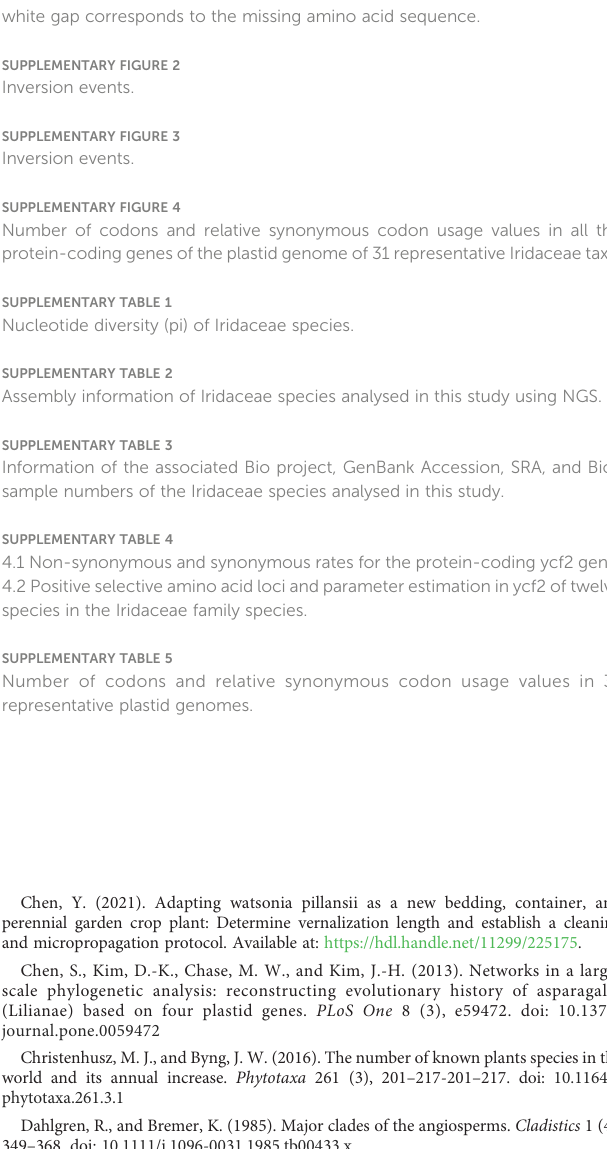
SUPPLEMENTARY FIGURE 1 Gene locus deletion in ycf 2 gene shared by the sampled species of three subfamilies — Crocoideae, Nivenioideae and Aristeoideae — of Iridaceae. The white gap corresponds to the missing amino acid sequence. SUPPLEMENTARY FIGURE 2 Inversion events. SUPPLEMENTARY FIGURE 3 Inversion events. SUPPLEMENTARY FIGURE 4 Number of codons and relative synonymous codon usage values in all the protein-coding genes of the plastid genome of 31 representative Iridaceae taxa. SUPPLEMENTARY TABLE 1 Nucleotide diversity (pi) of Iridaceae species. SUPPLEMENTARY TABLE 2 Assembly information of Iridaceae species analysed in this study using NGS. SUPPLEMENTARY TABLE 3 Information of the associated Bio project, GenBank Accession, SRA, and Bio- sample numbers of the Iridaceae species analysed in this study.